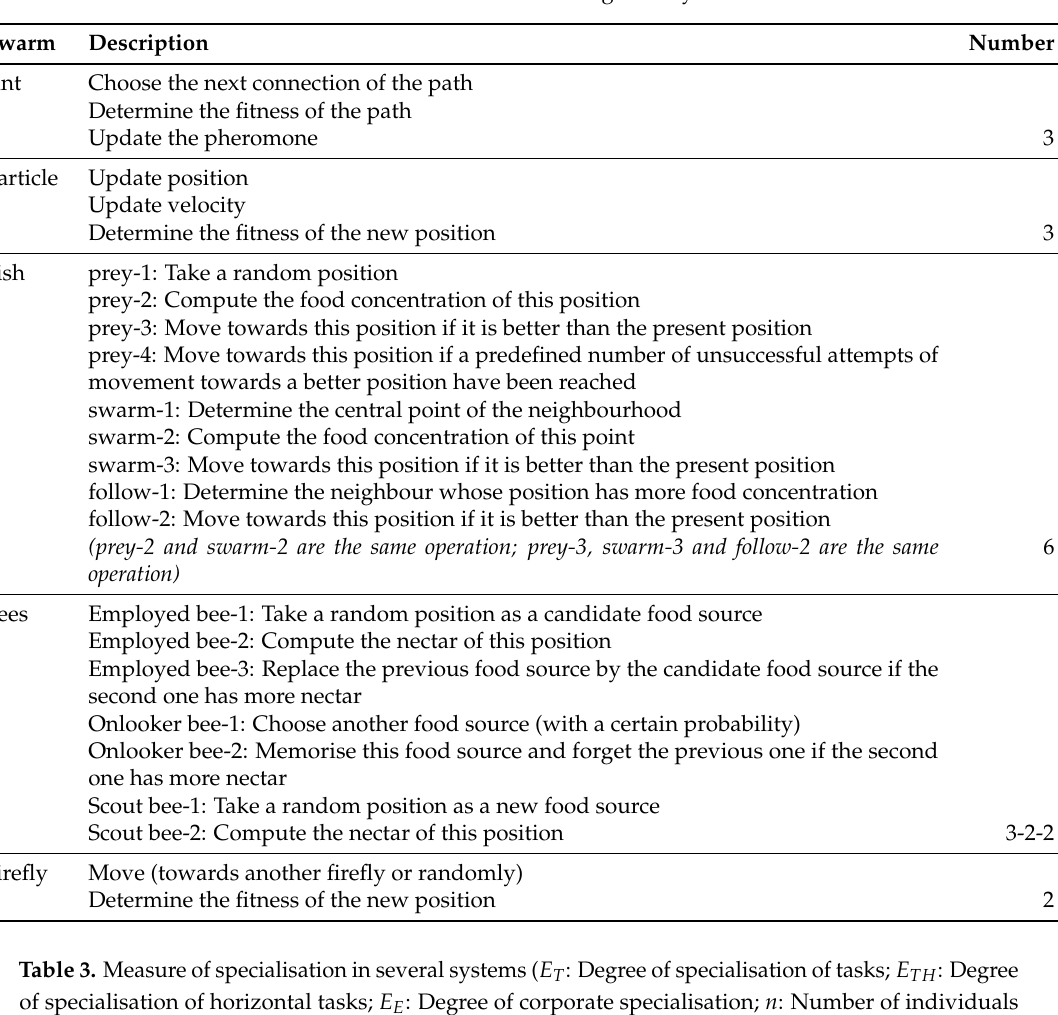
Table 2. Basic tasks of a single entity.